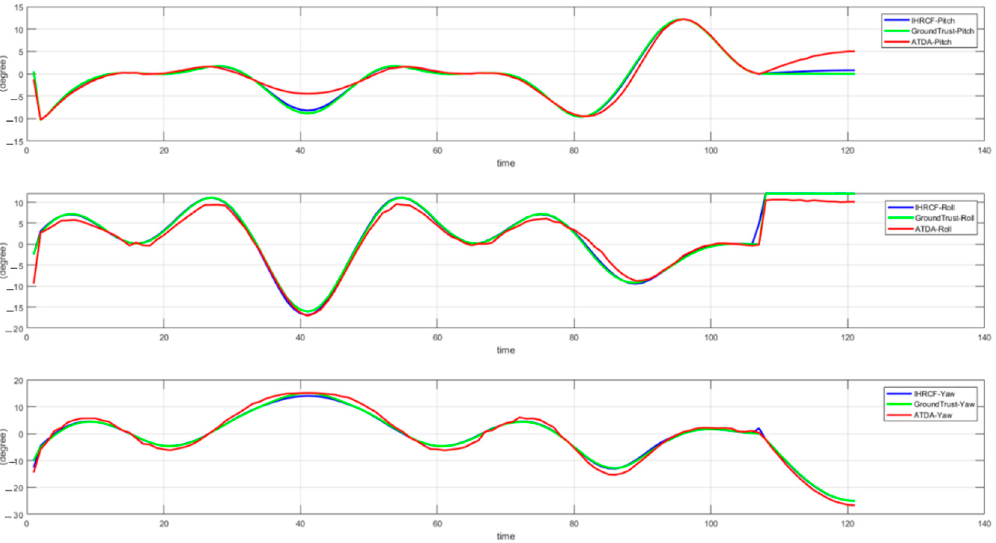
Figure 14. Euler angles, namely roll-pitch-yaw for the Stewart platform using IHRCF, GT, and ATDA.